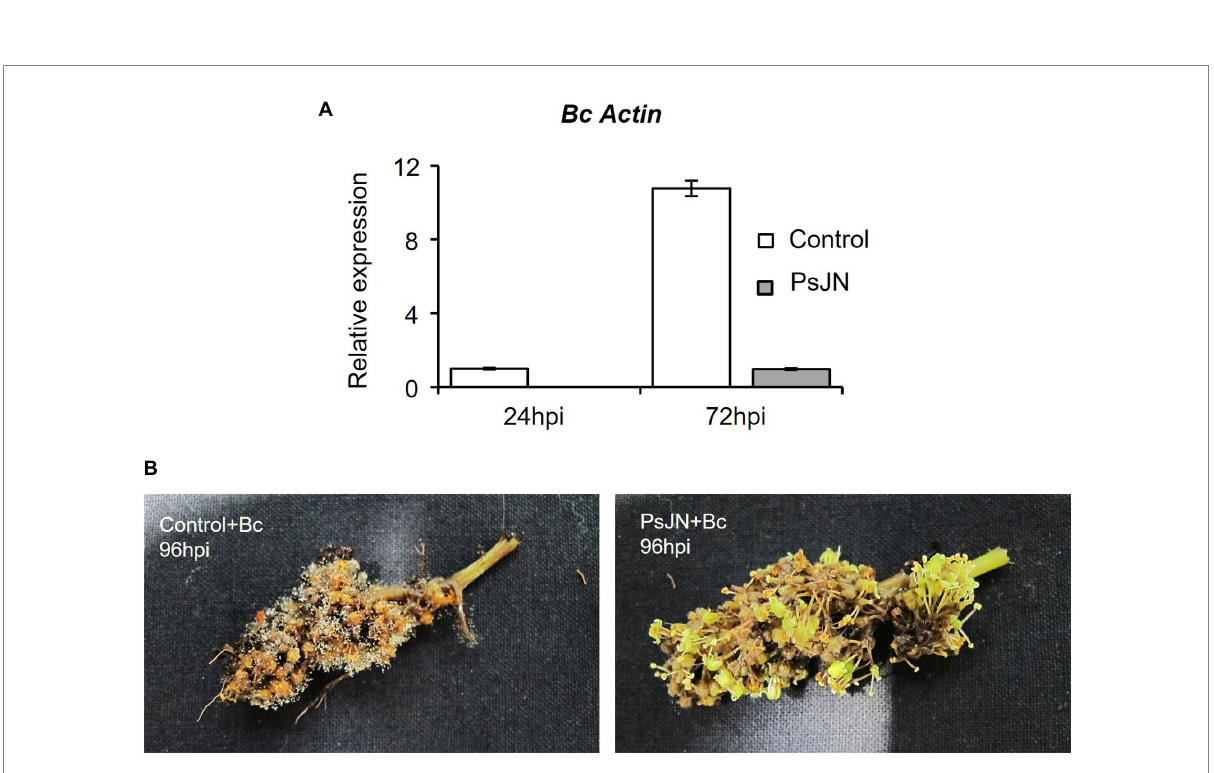
2016). VOCs emitted by plant associated bacteria are described as